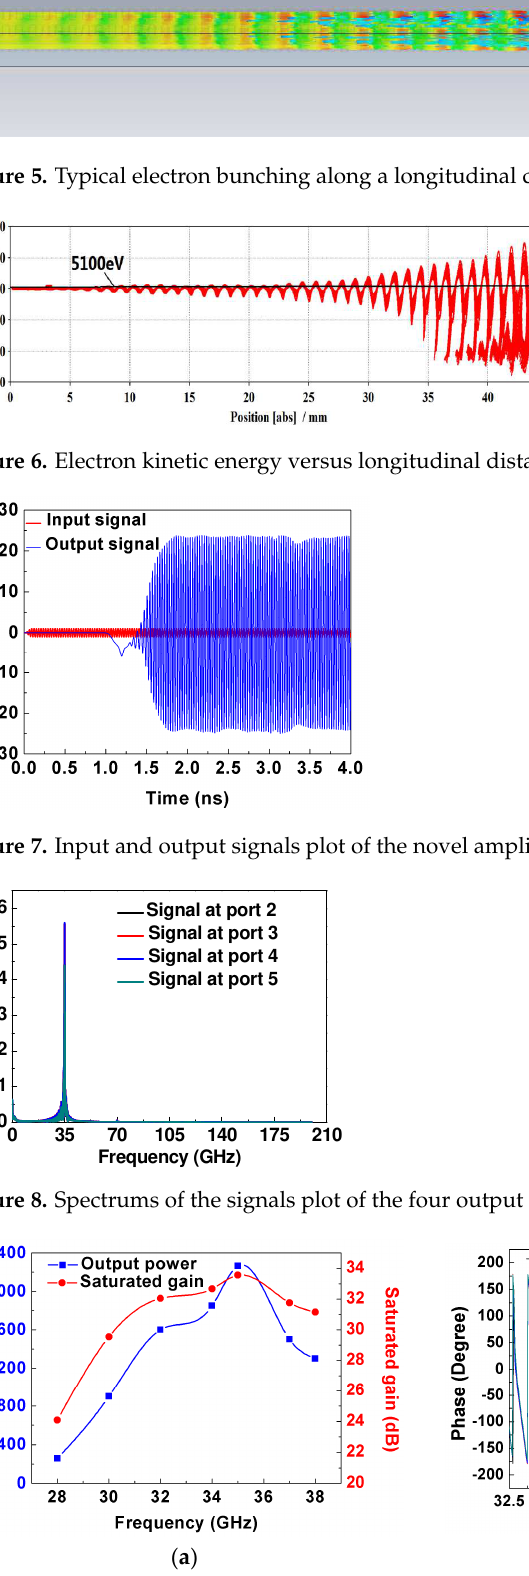
Figure 9. Plots of the simulated output power: the saturated gain ( a ); the phase congruency ( b ) for four output ports versus frequency.